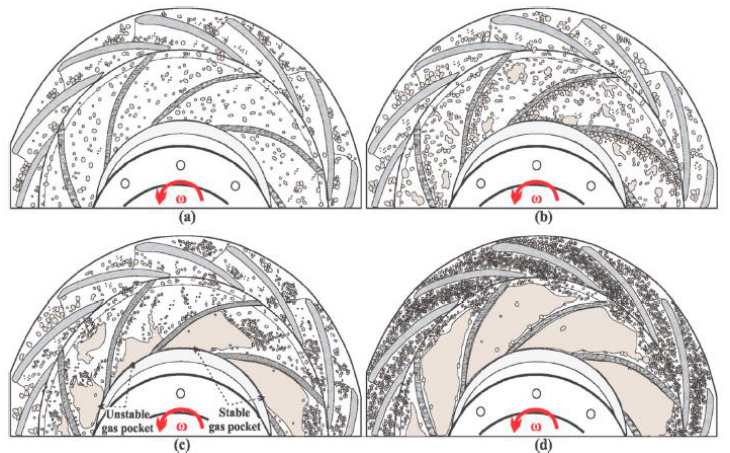
Figure 9. Gas–liquid flow structures in impeller and diffuser flow channels [60]. ( a ) Bubbly flow; ( b ) agglomerated bubbly flow; ( c ) gas pockets; ( d ) annular flow. ( b ) agglomerated bubbly flow; ( c ) gas pockets; ( d ) annular